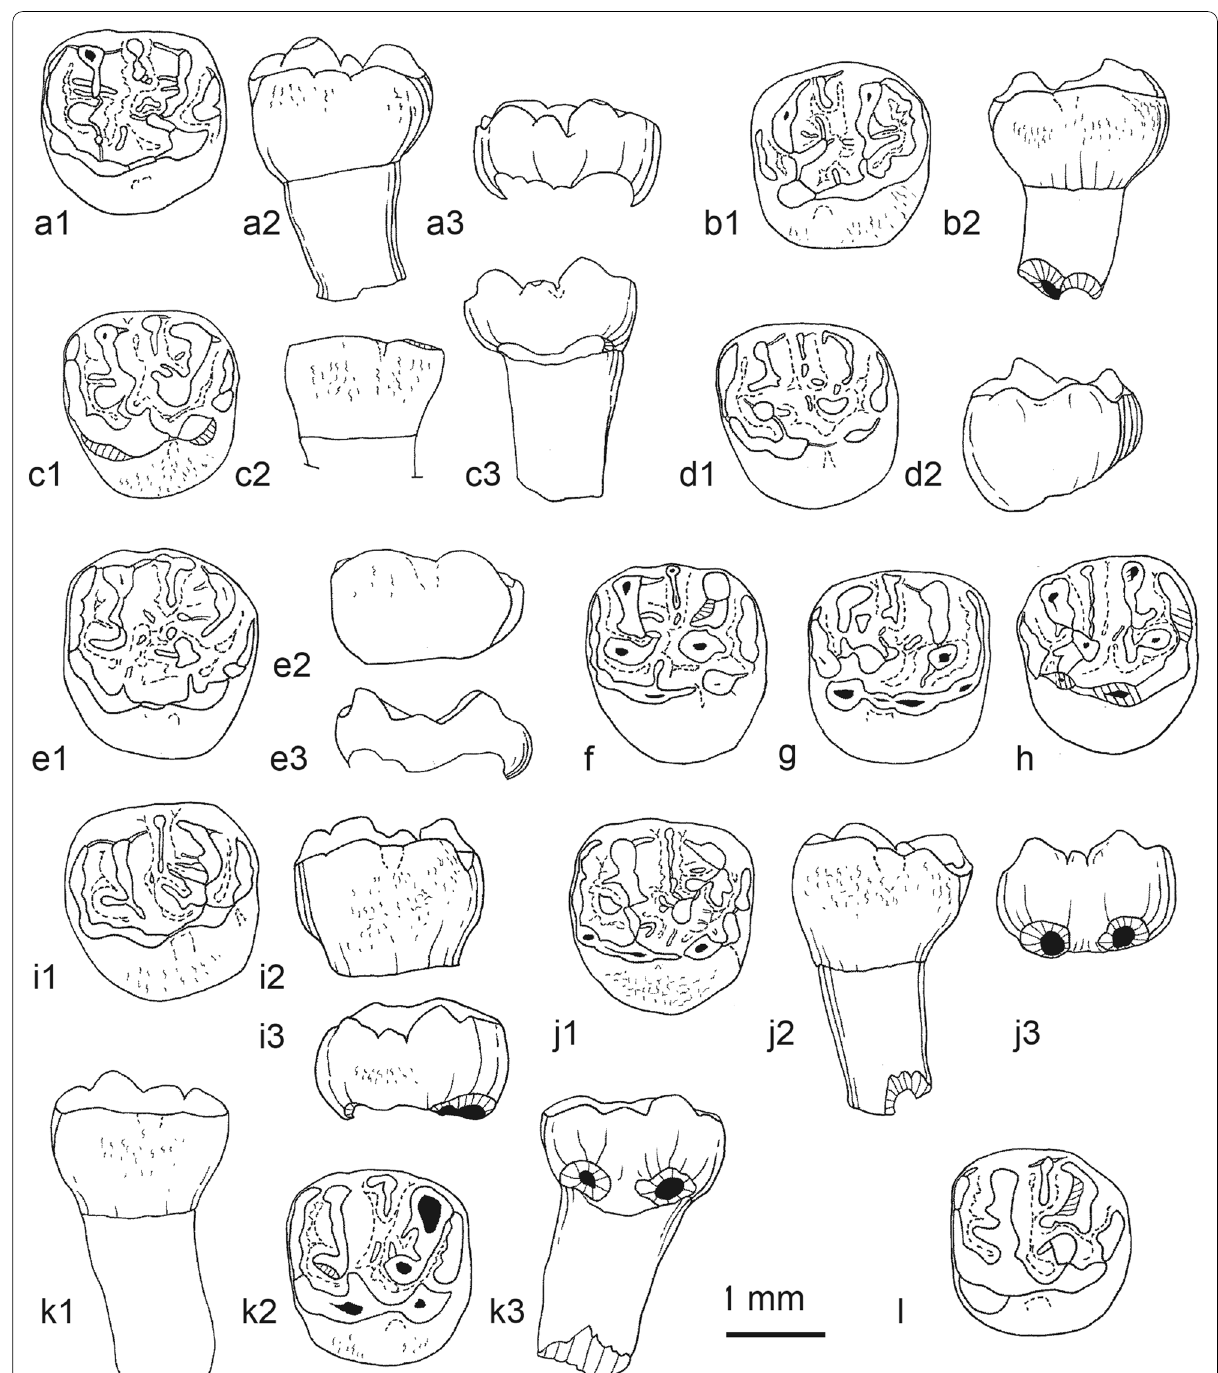
Fig. 31 Upper M2 of ? Protadelomys alsaticus Hartenberger, 1969 from Bouxwiller (Bas‑Rhin). a BUX67‑2, left M2, Holotype; a1, occlusal view; a2, lingual aspect; a3, buccal aspect. b CH43, right M2; b1, occlusal view; b2, lingual aspect. c : CH41, left M2; c1, occlusal view, c2, lingual aspect; c3, buccal aspect. d CH32, left M2; d1, occlusal view; d2, lingual aspect. e BUX67‑44, left M2; e1, occlusal view; e2, lingual aspect; e3, buccal aspect. f CSBX69, left M2; occlusal view. g CSBX33, right M2; occlusal view. h BUX67‑6, right M2; occlusal view. i BUX67‑56, left M2; i1, occlusal view; i2, lingual aspect; i3, buccal aspect. j : BUX67‑72, left M2; j1, occlusal view; j2, lingual aspect; j3, buccal aspect. k : BUX67‑52, left M2; k1, lingual aspect; k2, occlusal view; k3, buccal aspect. l : BUX67‑79, left M2; occlusal view. Scale bar: 1